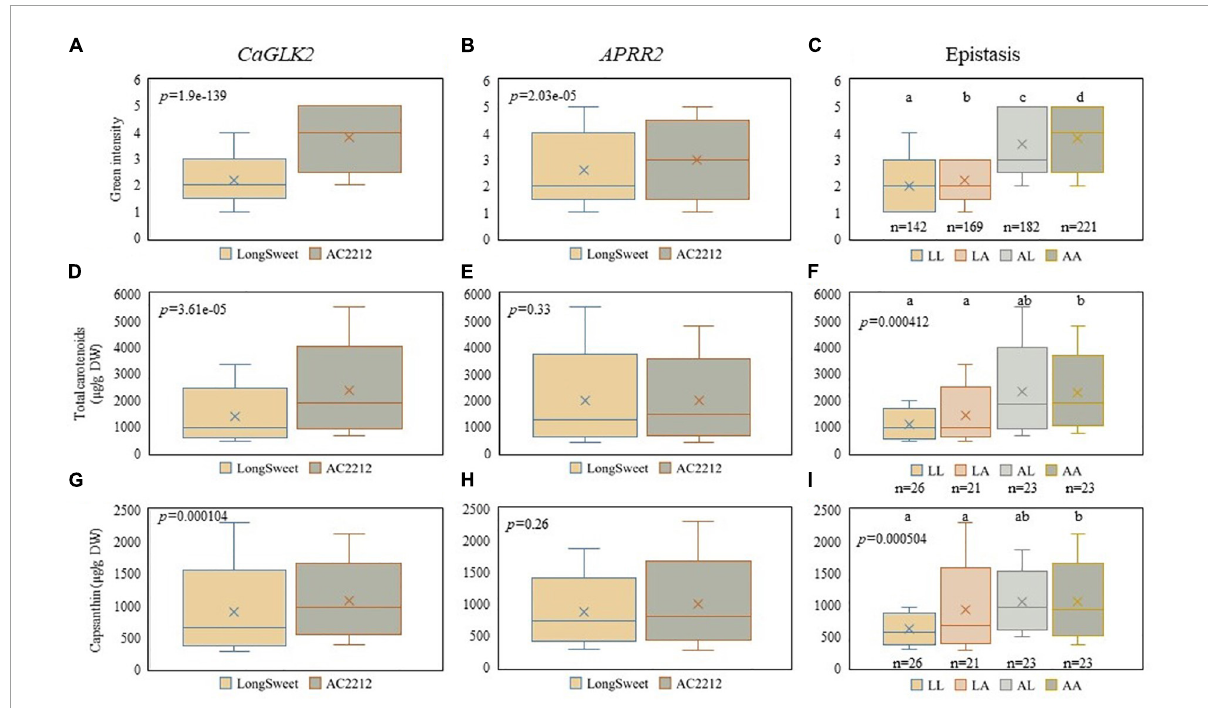
FIGURE5 Comparison between genes related to chlorophyll synthesis and carotenoid contents. Boxplots of green fruit color intensity distribution and (A) CaGLK2 , (B) APRR2 , and (C) both genes. Boxplots of total carotenoid contents ( µ g/g DW) distribution and (D) CaGLK2 , (E) APRR2 , and (F) both genes. Capsanthin contents ( µ g/g DW) distribution regulated by (G) CaGLK2 , (H) APRR2, and (I) interaction of two